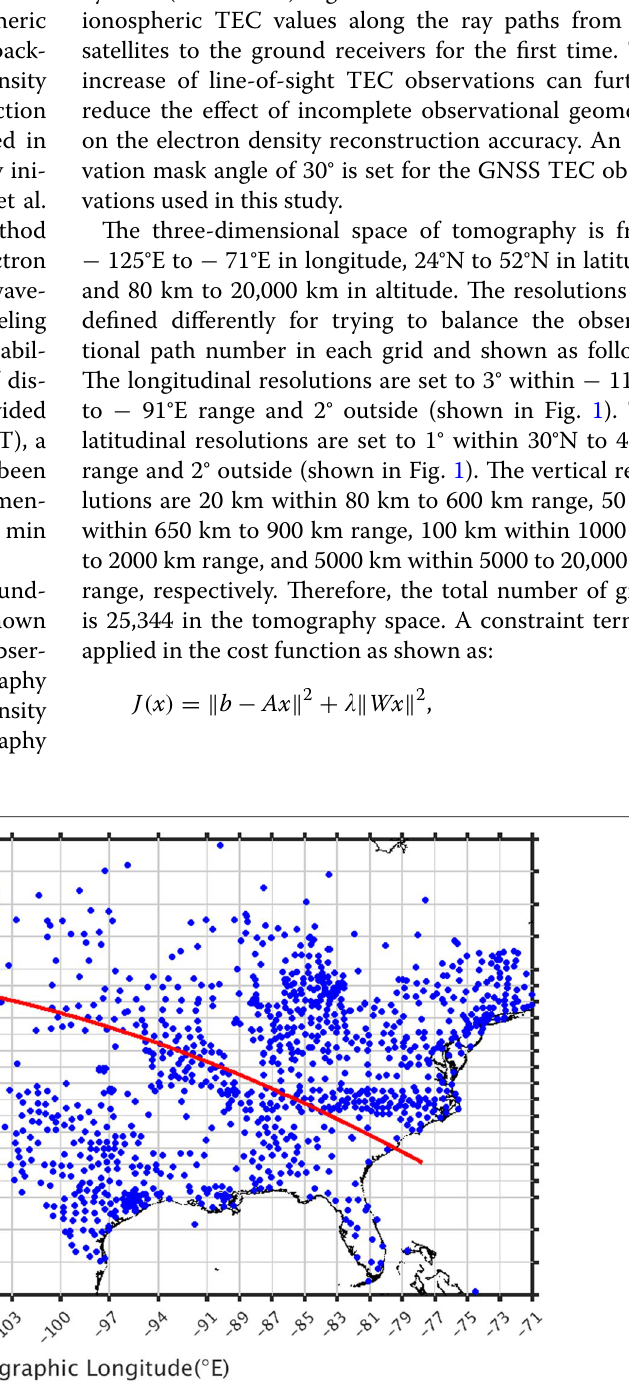
Fig. 1 The location of ~ 2000 ground-based GNSS receivers at Northern America. The blue dot is the GNSS receiver, and the red line indicates the path of total